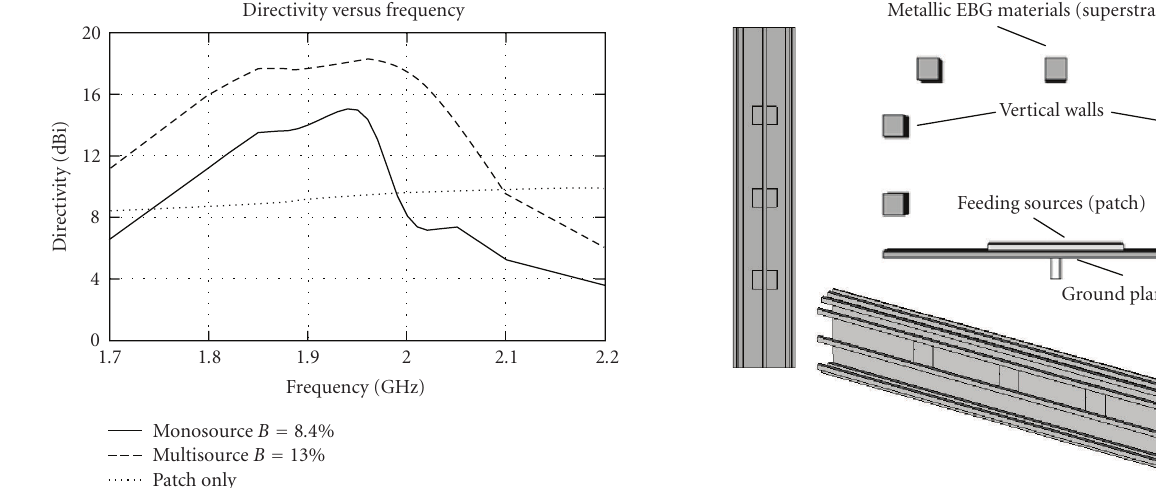
Figure 13: Directivity evolution for the two cases.